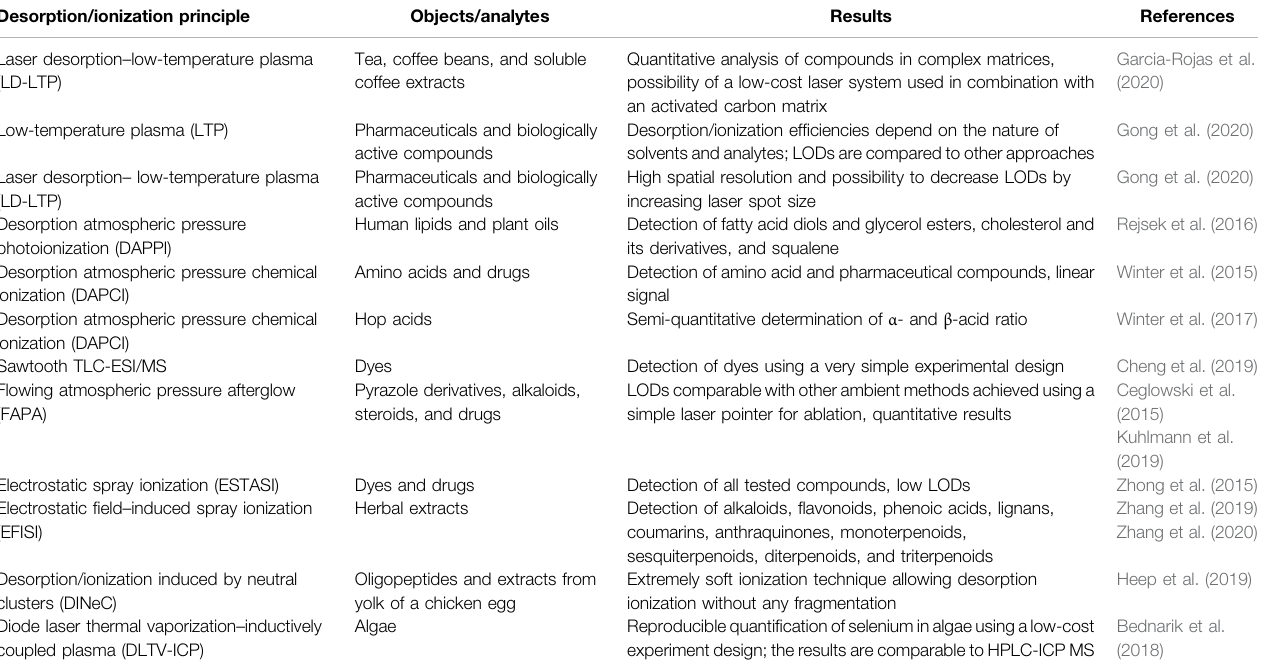
TABLE 1 | Home-built interfaces for TLC/MS